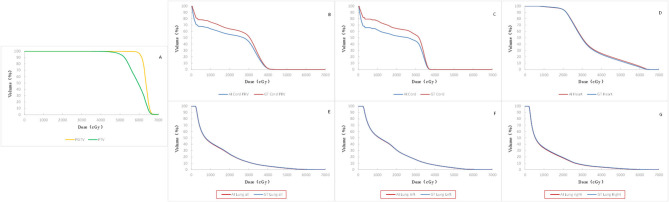
Comparison of mean DVH of all the 19 cases. Red solid line: automatic segmentation Blue solid line: manual segmentation including DVH of targets (A), spinal cord PRV (B), spinal cord (C), heart (D), bilateral lung (E), left lung (F), and right lung (G).